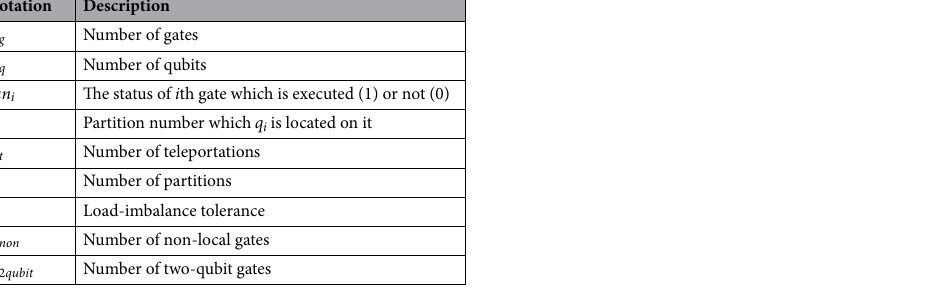
Table 1. The notation of the proposed